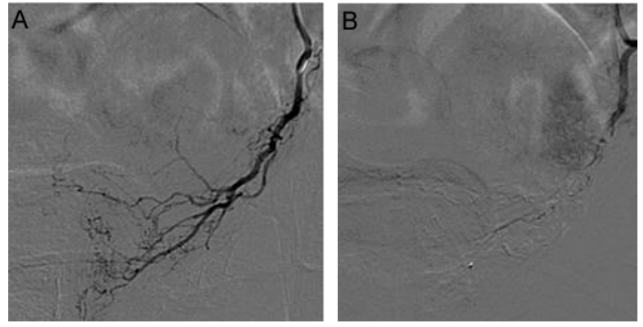
Figure 1. a,b. (a) Axial T1-weighted angiography images show pre-procedural. (b) Coronal T1-weighted angiography images show